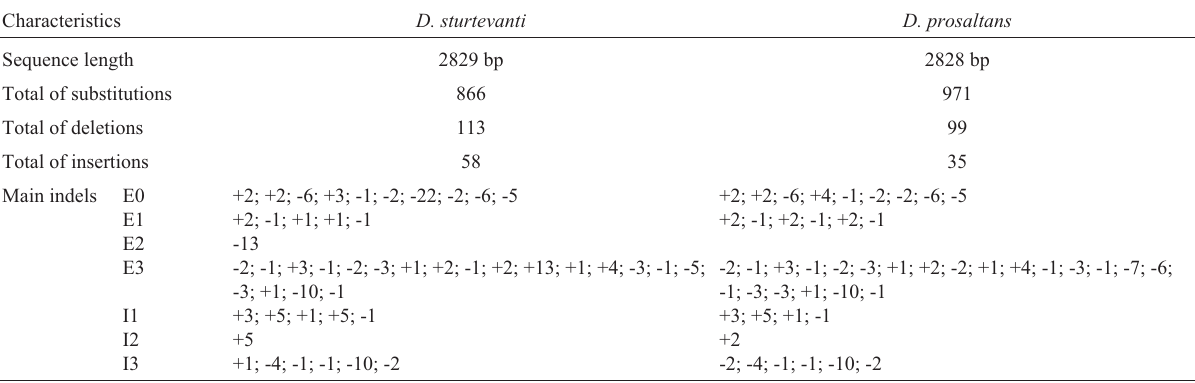
Table 1 - Differences observed between Drosophila sturtevanti and D. prosaltans P element sequences and that of the canonical P element of D. melanogaster.